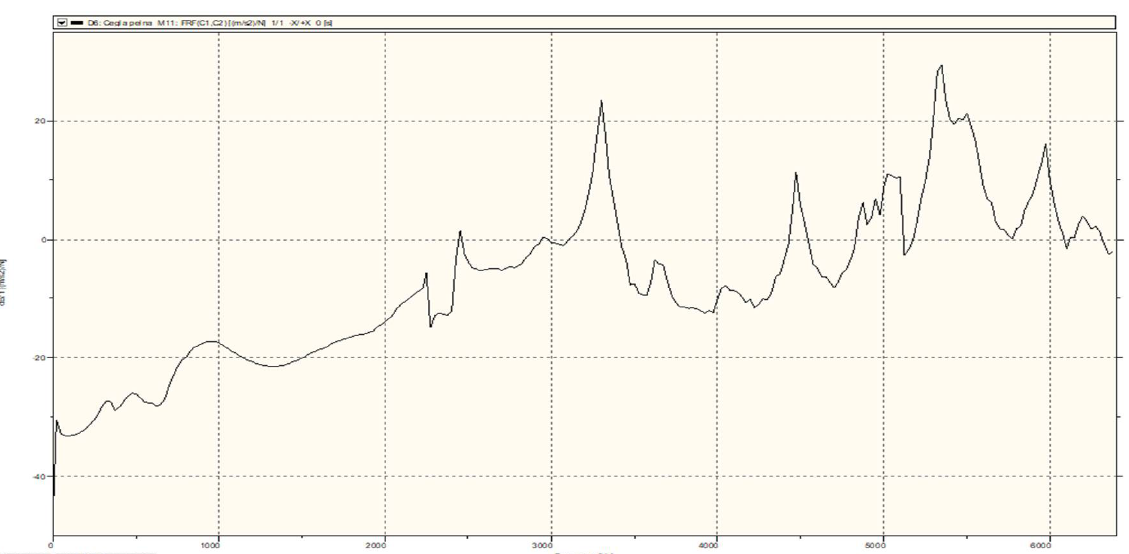
Figure 5. Distribution of measurement points on the research object.